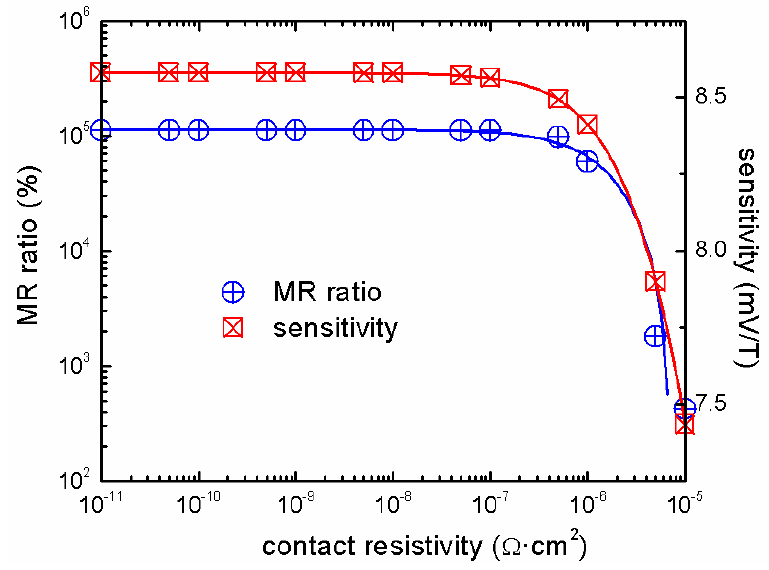
Figure 9. MR ratio and sensitivity as a function of the contact resistivity at 1 T (MR ratio and contact resistivity axes are logarithmic). The bias current is 0.1